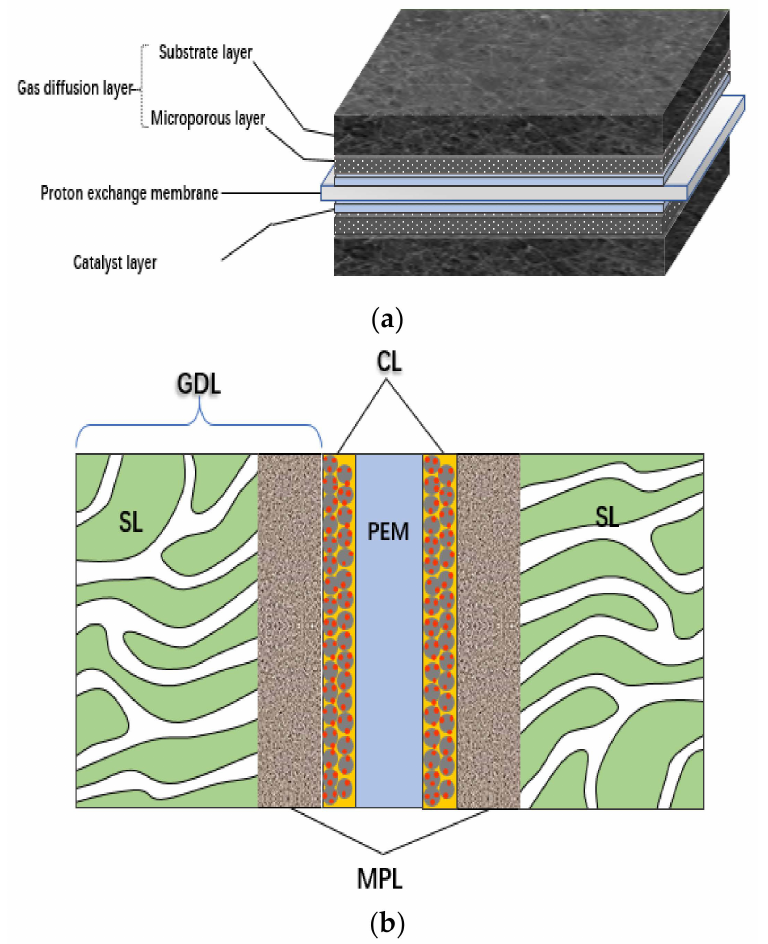
Figure 1. ( a ) Schematic diagram of MEA structure and composition. ( b ) Schematic diagram of MEA